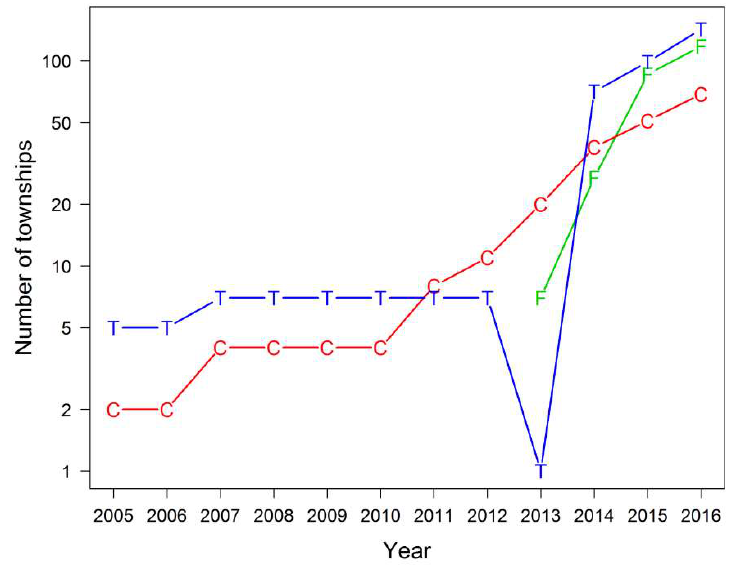
Figure 1. Number of townships in different types of integrated TB/HIV services (2005–2016). F = fully integrated model; C = partially integrated model: TB and HIV services co-existed; T = partially integrated model: TB services only.